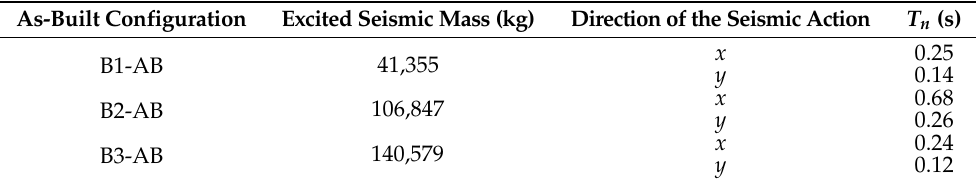
Table 12. Values of the natural period for the as-built configurations. As-Built Configuration